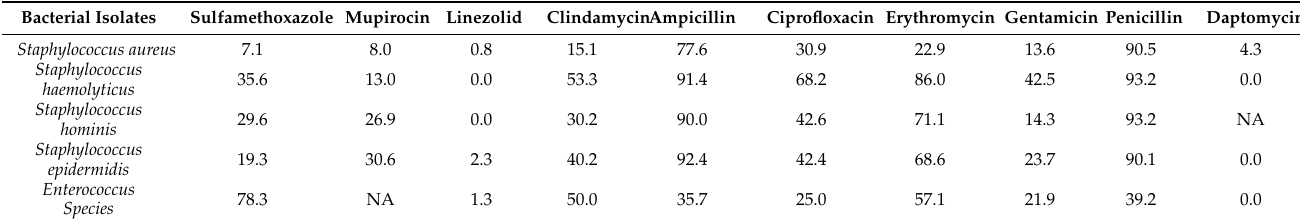
Table 7. Gram-positive bacterial resistance rates in patients less than 48 years